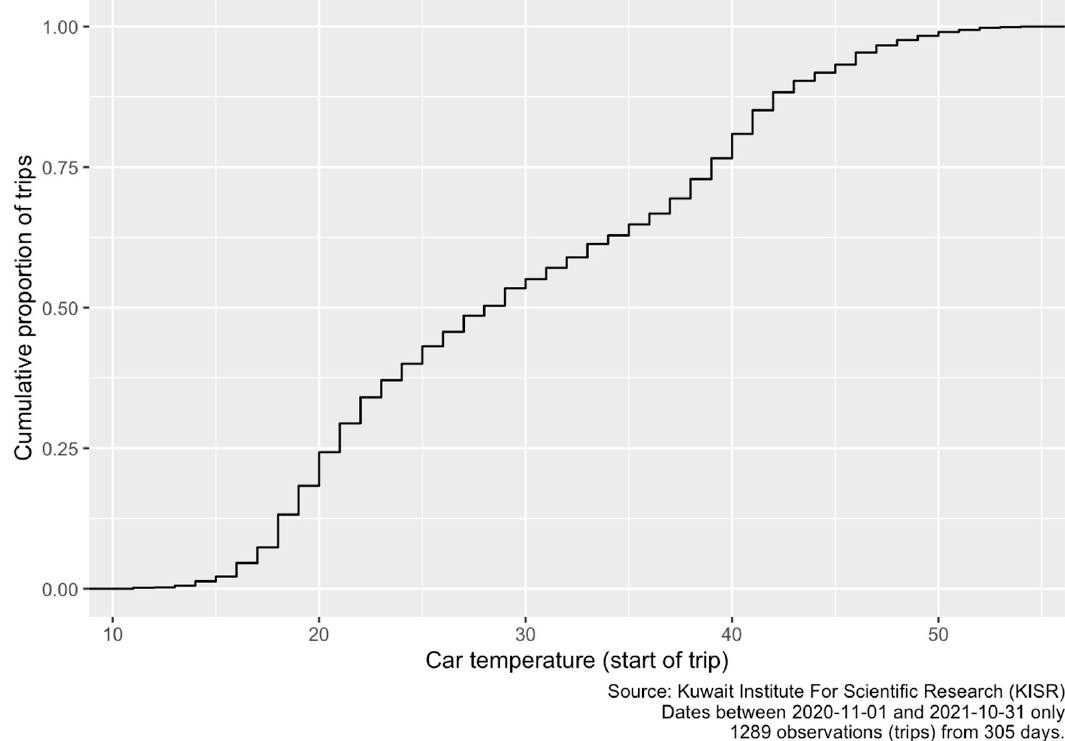
Figure 4. Cumulative distribution of trips by temperature, November 2020 to October 2021 only (avoiding period of COVID-19 restrictions).